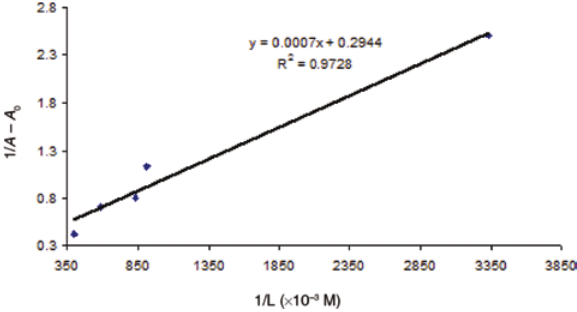
Figure 3: FT-IR spectra of the free calf thymus DNA-STZ complexes at different molar ratios in the region of 1800–600 cm −1 in aqueous